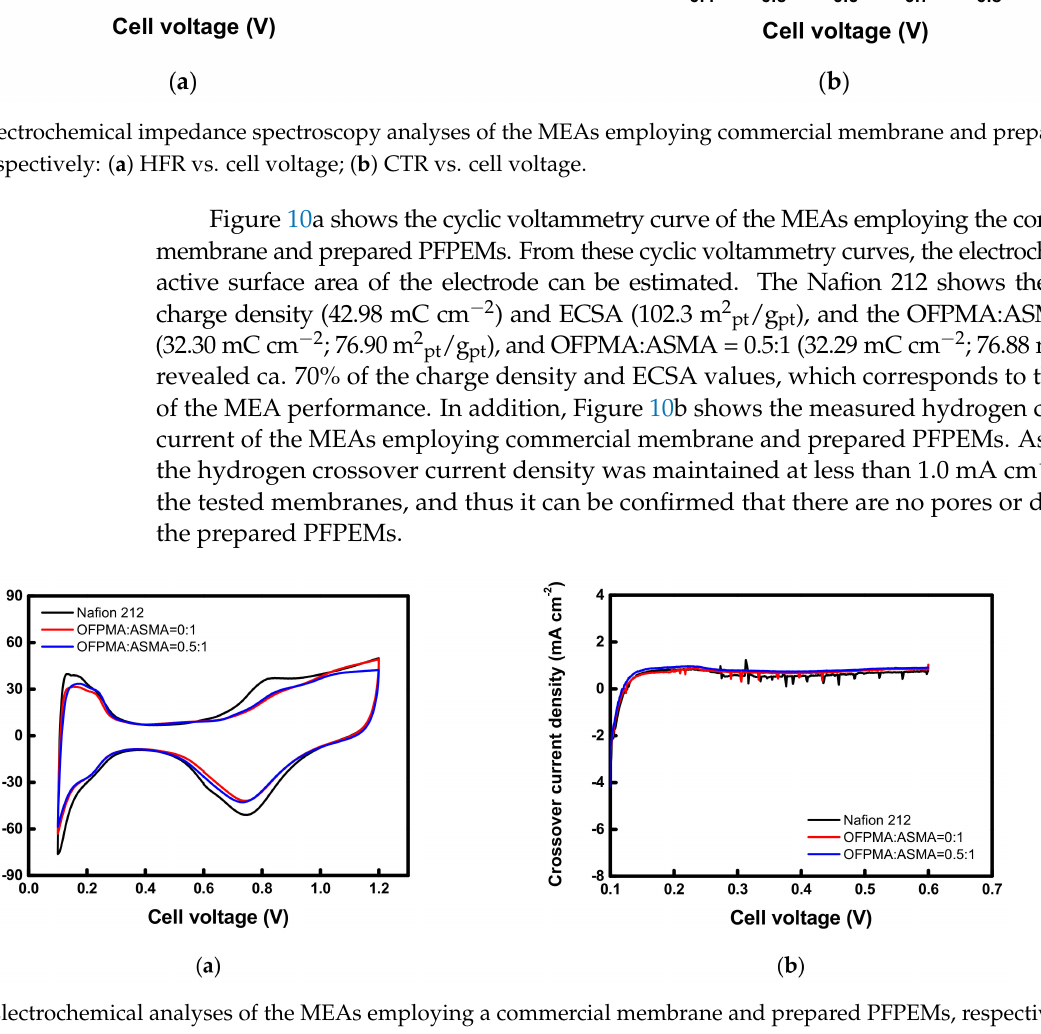
Figure 9. Electrochemical impedance spectroscopy analyses of the MEAs employing commercial membrane and prepared PFPEMs, respectively: ( a ) HFR vs. cell voltage; ( b ) CTR vs. cell voltage.